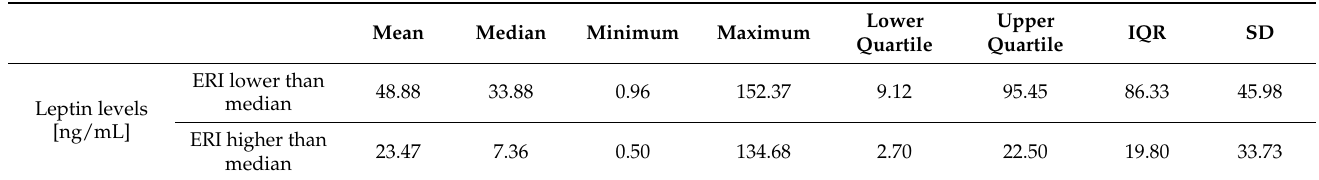
Table 4. Comparison of leptin levels among groups with higher and lower erythropoietin resistance index (ERI). Median ERI in the whole study group was 4.89; n = 78.